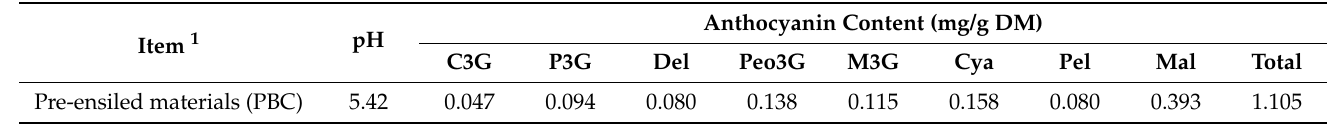
Table 2. pH and anthocyanin concentration of anthocyanin-rich black cane prior to ensiling (pre- ensiled materials) and its silages at 42 d after